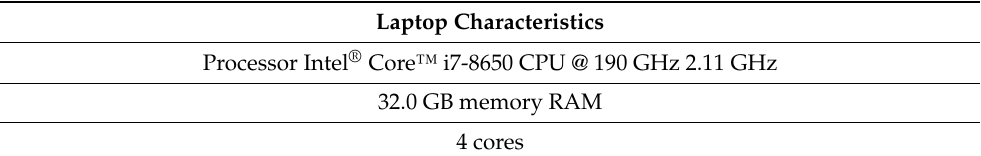
Table A12. Characteristics of the laptop used in the research project.